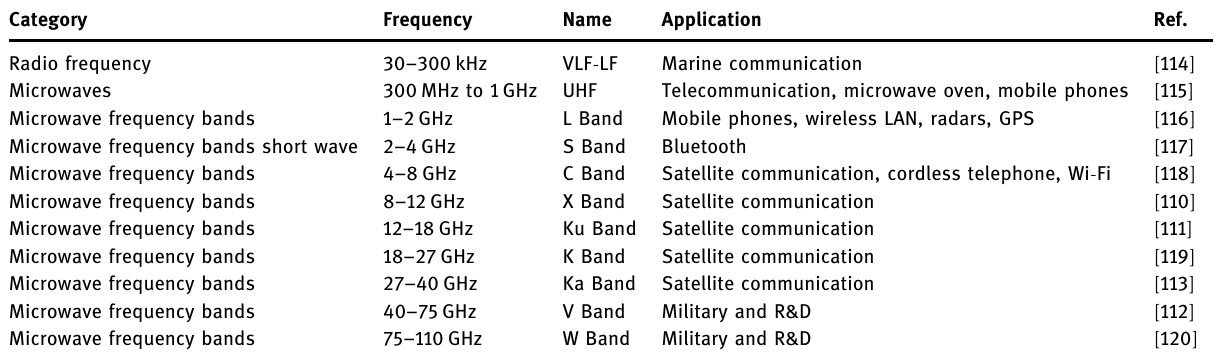
Table 2: Communication devices and their frequency range Category